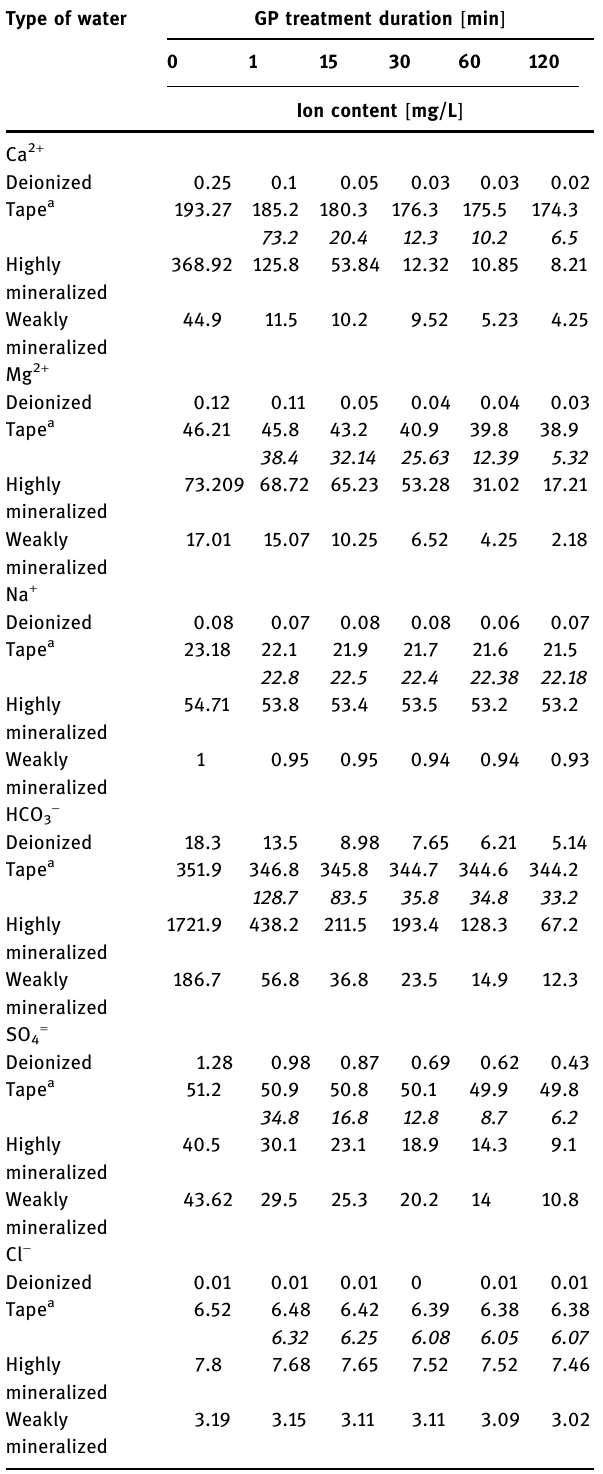
Table 5: Amount of ions [ mg/L ] remaining in the treated water containing 0.5 and 10% ammonia after separation of